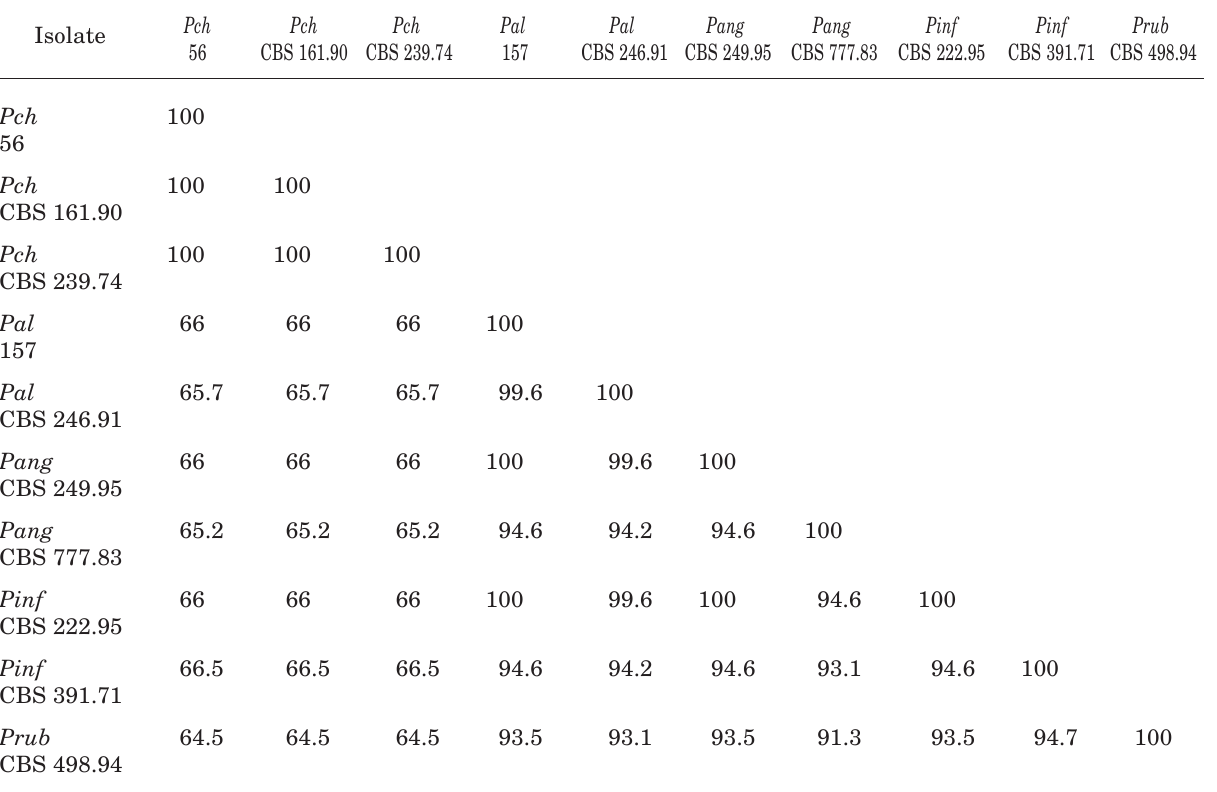
Table 4. Similarity matrix derived from the sequence data of ITS region in the Phaeoacremonium species exam- ined. Abbreviations: Pch , P. chlamydosporum ; Pal, P. aleophilum; Pang, P. angustius; Pinf, P. inflatipes; Prub, P. rubrigenum